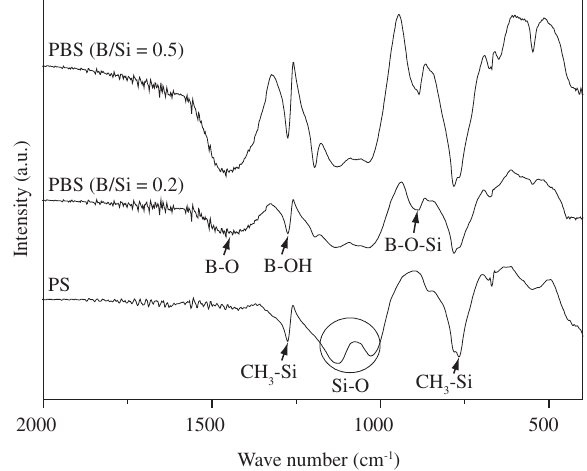
Figure 1. FTIR spectra of PS and PBS gels derived from